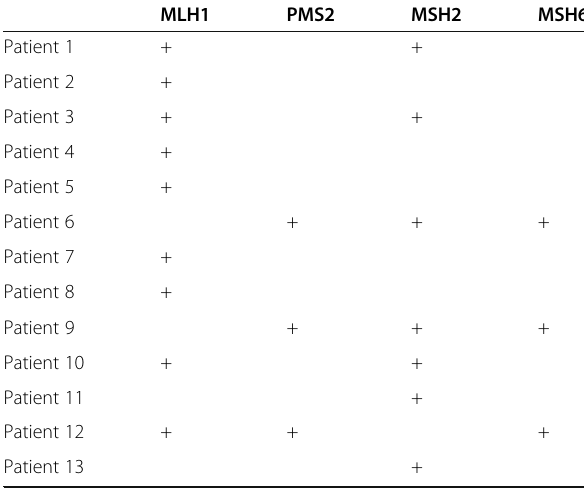
Table 3 Patients with loss of MMR protein expression (+ indicates presence of loss of MMR protein expression by IHC) MLH1